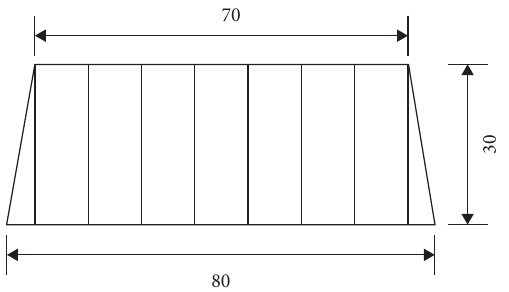
Figure 1: Schematic diagram of the trapezoidal transparent plastic plate